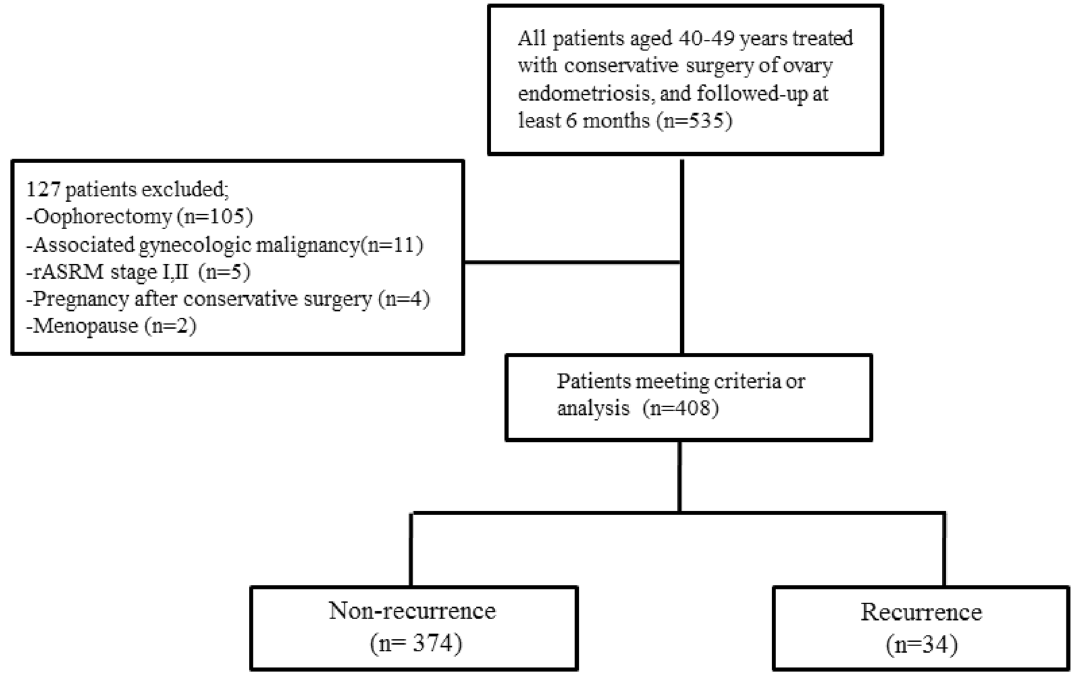
Figure 1. Flow diagram of patient selection